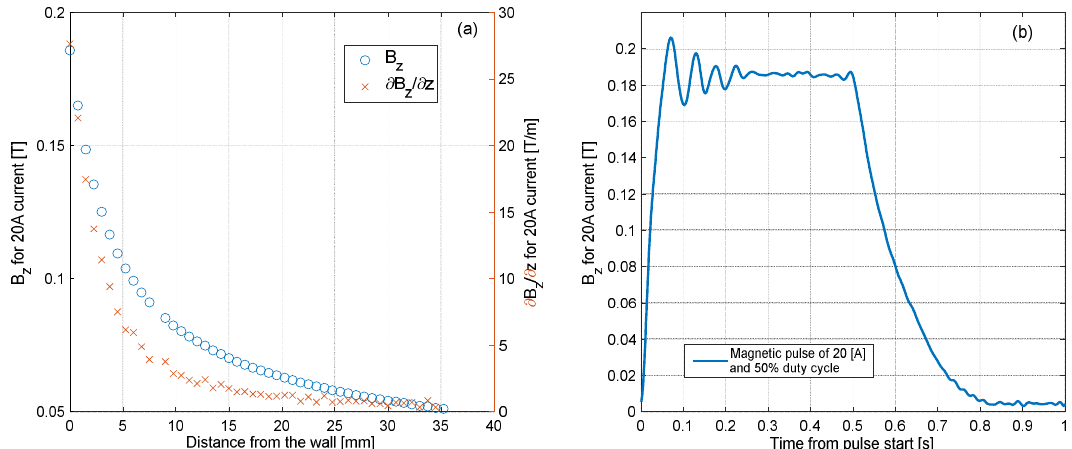
Figure 2. Characterization of the electromagnetic field. ( a )—Electromagnetic field and its gradient, against distance from the inner wall. ( b )—The pulse of the electromagnetic field varies in time.